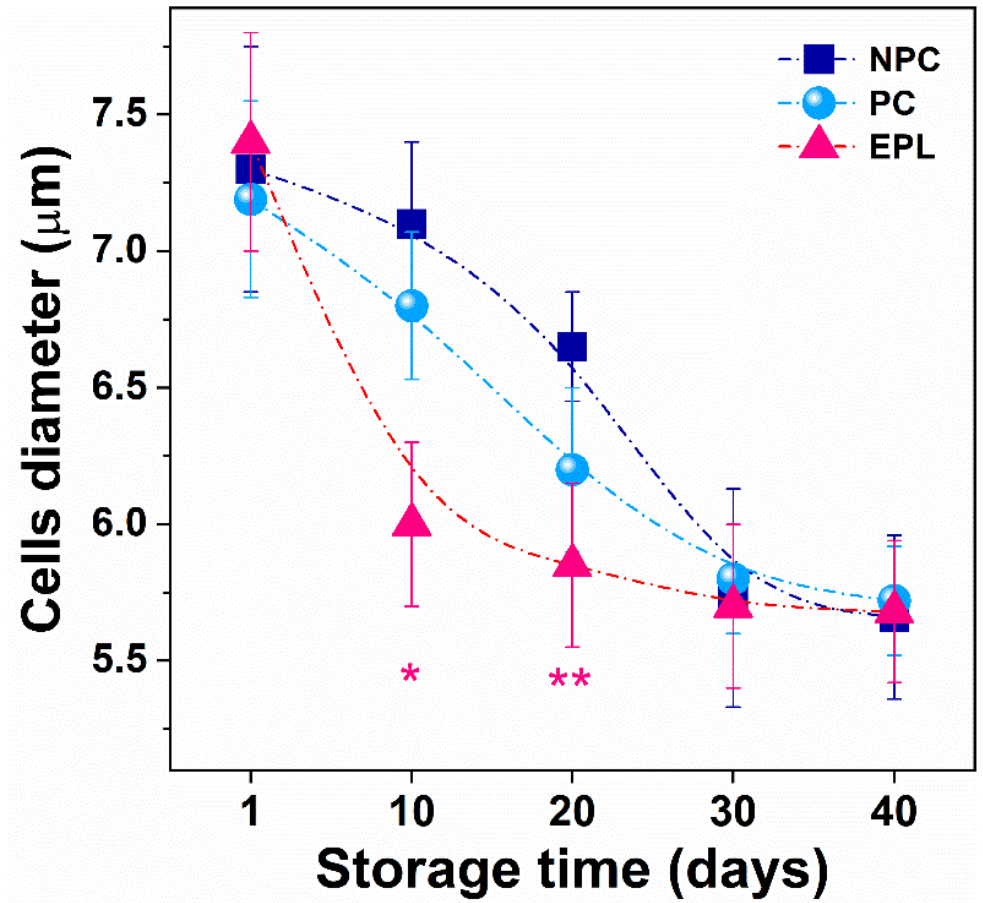
Figure 4. Alteration in the erythrocyte’s diameter determined for cells isolated from nonpregnant controls (NPC, dark blue square), pregnant controls (PC, light blue sphere), and women with early pregnancy loss (EPL, red triangle) as a function of the aging time of cells. Mean values and SD. Non-parametric Wilcoxon test was used to determine statistical differences in the value of the diameter of EPL cells, which are given as p values, indicated as * p < 0.05 relative to both NPC and PC, ** p < 0.05 relative to NPC. Figure 5B–J reveals the ultrastructural changes of erythrocytes’ membrane derived from the three studied groups. The membrane surface of healthy NPC and PC erythro- cytes appeared homogeneous throughout the storage period with gradual smoothing of the structure, particularly at the later stage (Figure 5D,G). In contrast, the surface of fresh EPL erythrocytes was heterogeneous with irregularly dispersed small lumps (Figure 5H). An important feature of EPL erythrocytes was the faster occurrence of structural alterations and the appearance of microvesicles at later storage times (Figure